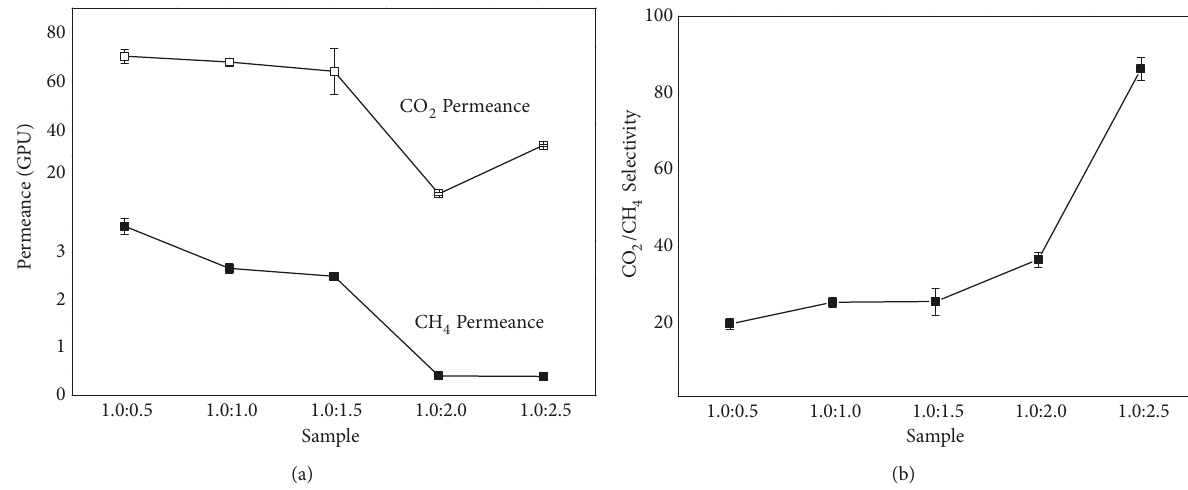
Figure 6: Separation performance of PC-Sil-IL at different IL:Si ratio at 2 bar with (a) gas permeance and (b) CO 2 /CH 4 selectivity.